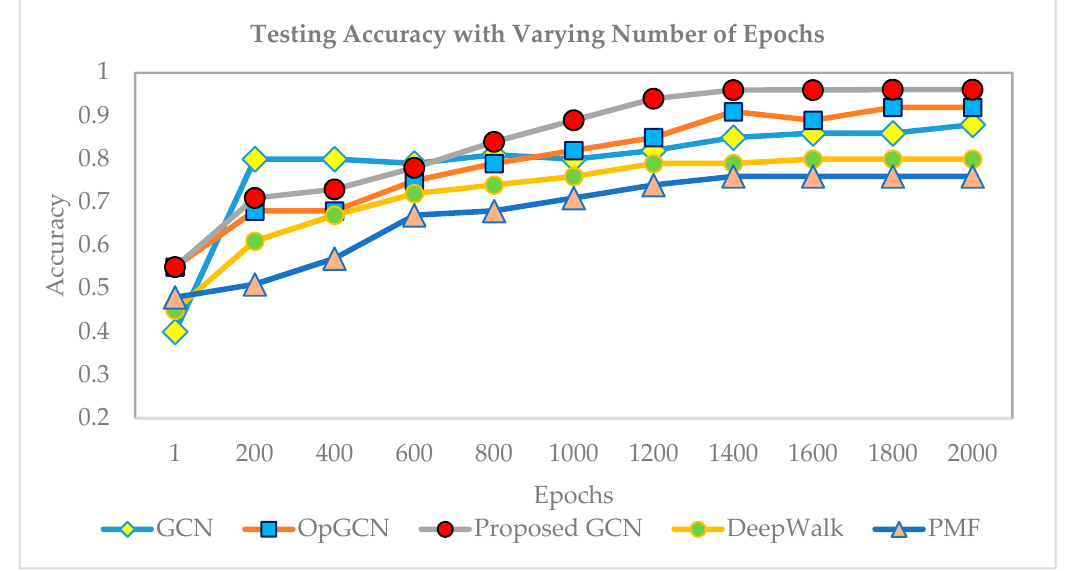
Figure 8. Testing accuracy against the number of epochs.